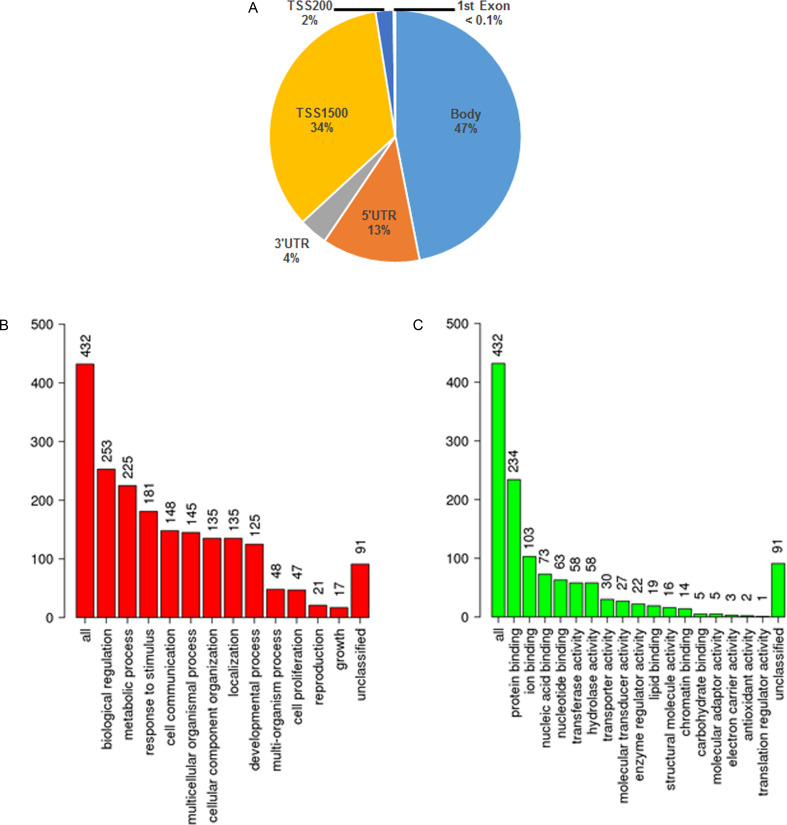
Pathway analysis for the 714 differentially methylated positions.(A) Number of probes by genomic location. B-C) Pathway analysis for the 432 genes associated with the 714 DMPs by biological process categories (B) and molecular function categories (C).